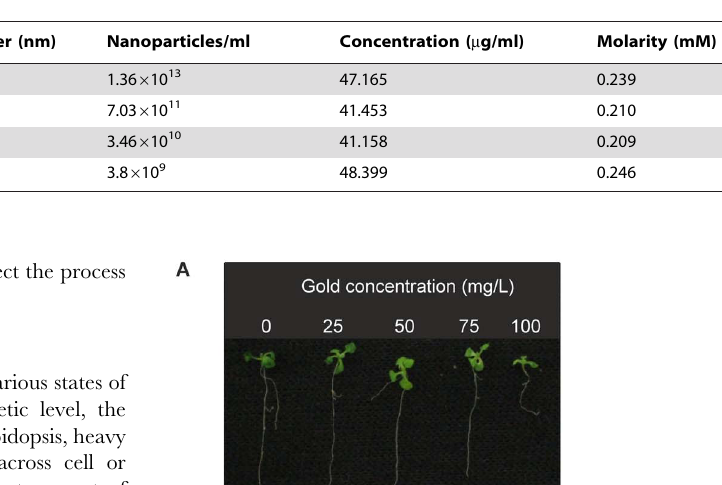
Table 1. Properties of nanoparticles used in this study.